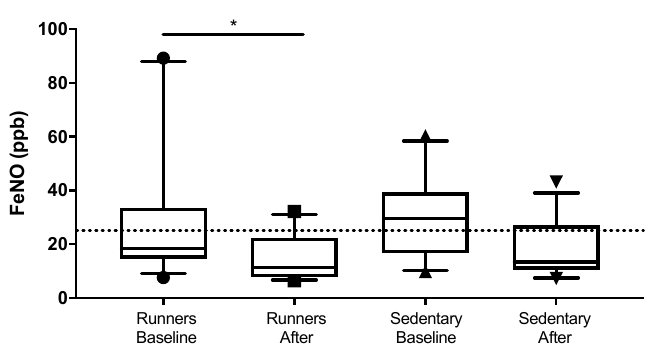
Figure 4. FeNO levels of runners and sedentary people at the baseline and after winter were characterized by median, and maximum and minimum values. There was a significant decrease in FeNO in the runners’ group after ten weeks of exposure to higher PM levels. Sedentary people did not show a significant difference between the moments. A dashed line represents the cut value used for the diagnosis of lung inflammation according to ATS/ERS [22]. The Wilcoxon test was used. p < 0.05. *Statistically significant difference between groups.